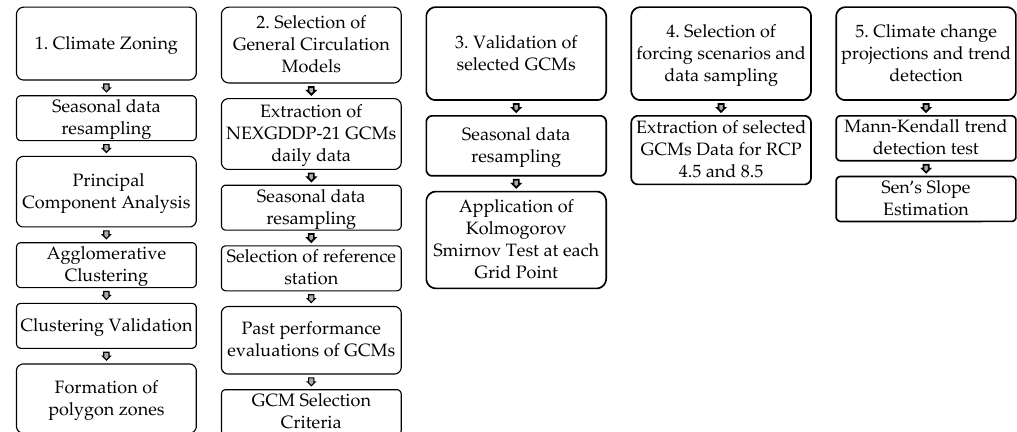
Figure 3. Flow chart of the methodology employed in this study.